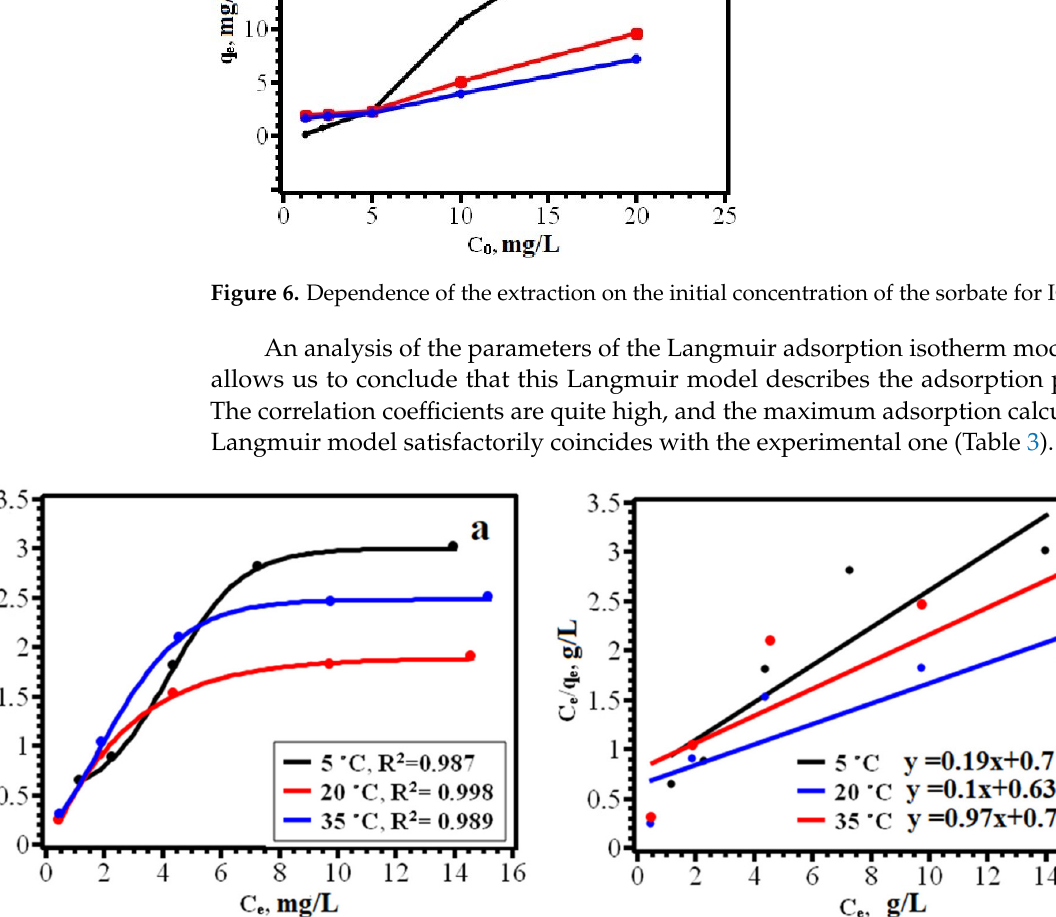
Figure 7. Langmuir isotherms of the solid-phase extraction of IC dye in non-linearized ( a ) and linearized ( b ) form.